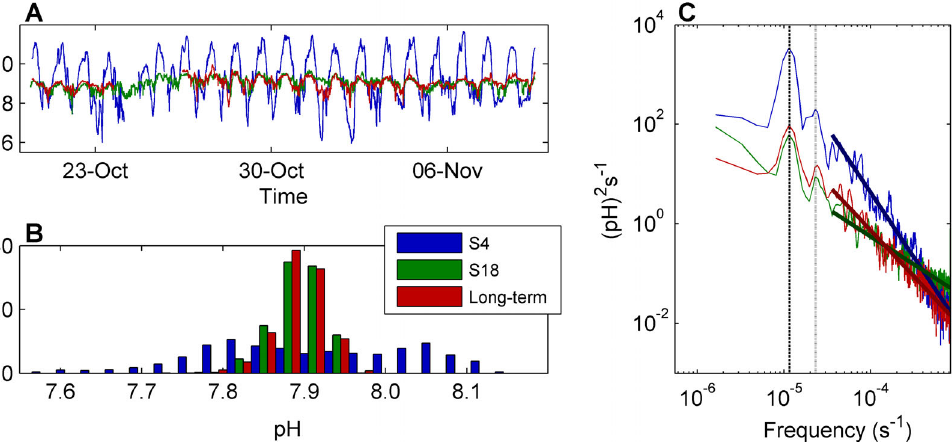
Figure 2. Example of 3 simultaneous time-series of pH. Simultaneous time-series of pH, taken from October 20th to November 9th 2011. The sites shown are: S4 (in blue), located 8.2 m offshore at a depth of 0.4 m, S18 (in green), located 31.6 m offshore at a depth of 3.7 m, and the long- term station (in red), located at 1.7 m depth over a bottom 3 meters deep. (A) Time series plot. (B) Histograms of frequencies of pH values during this period. (C) Power spectral densities. Darker straight lines in (C) depict the best fit power-law models between frequencies 1/8 h 2 1 and 3 h 2 1 obtained using linear least squares method. The vertical dashed and dotted lines in the spectra mark the diurnal and semi-diurnal frequencies respectively.